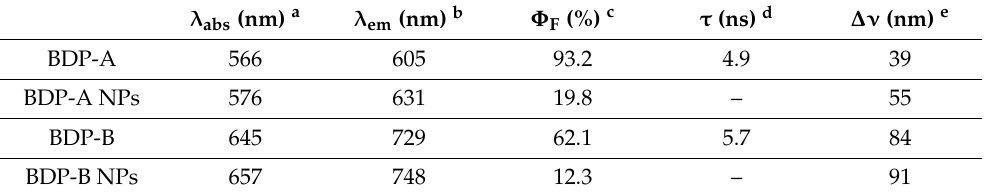
Table 1. Optical physical properties of BDP-A/B in dichloromethane and BDP-A/B NPs in water.